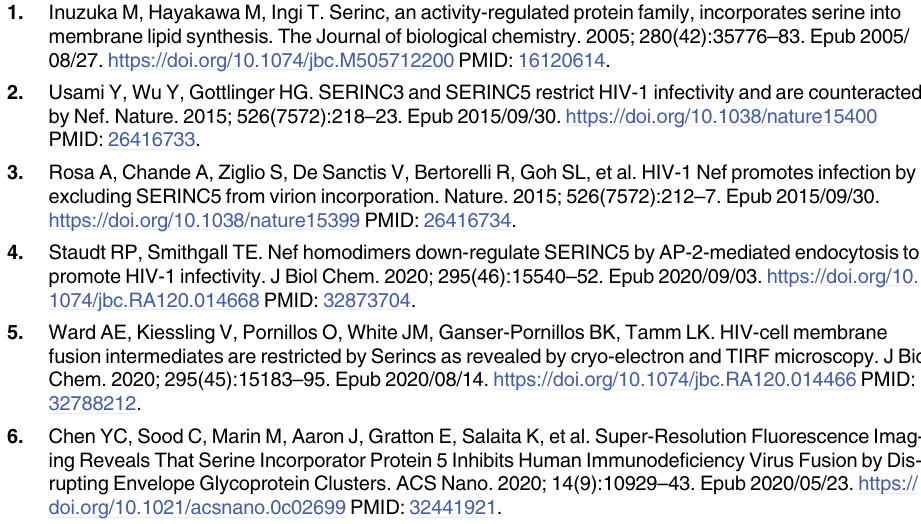
S1 Table. The glycosylation site on HA in different